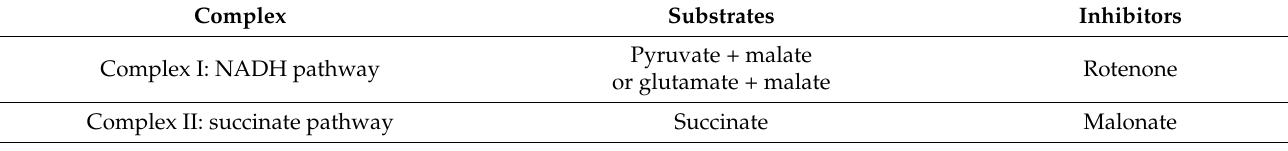
Table 6. Specific substrates and inhibitors to assess each mitochondrial pathway.